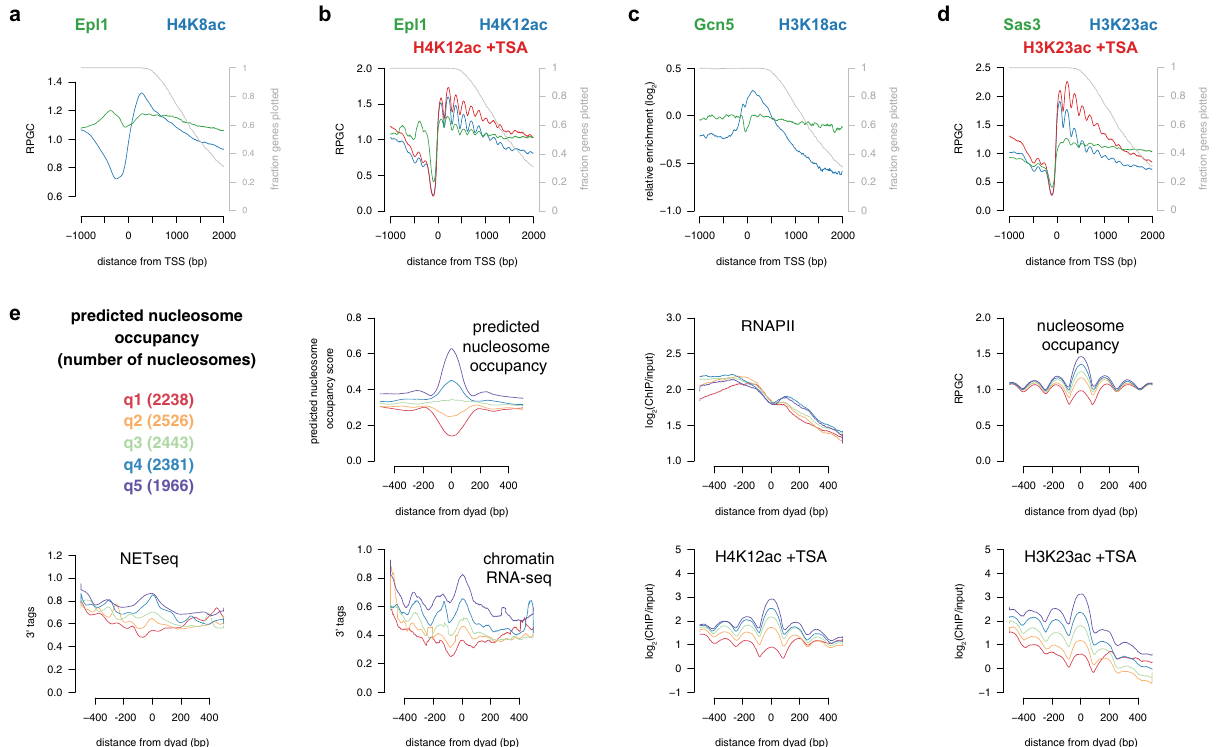
Fig. 3 The activity of histone acetyltransferases are regulated post-recruitment. a , b Average pro fi les of Epl1 (green) and H4 acetylation (blue) ChIP from sonicated 27 ( a ) or MNase-digested chromatin ( b ) at 832 unidirectional promoter genes aligned by the TSS. Only data until the PAS was included, and the gray line represents the fraction of genes plotted for each position. Data from TSA-treated cells (red) was normalized to untreated wild-type (see “ Methods ” ). RPGC reads per genomic coverage, TSS transcription start site. c , d Average pro fi les of Gcn5 (green) and H3K18ac (blue) ChIP 75 from sonicated chromatin ( c ) and Sas3 (green) and H3K23ac (blue) ChIP from MNase-digested chromatin ( d ) at 832 unidirectional promoter genes aligned by the TSS. e Genic nucleosomes 47 in the middle quintile for RNAPII occupancy [log 2 (Rpb3/input) 50 bp upstream and downstream of the nucleosome dyad] were divided into quintiles based on predicted nucleosome occupancy 48 over the same region. Shown are pro fi les upstream and downstream of the nucleosome dyad for predicted nucleosome occupancy, RNAPII (Rpb3 ChIP-seq 73 ), nucleosome occupancy (MNase-seq), NET-seq 41 , chromatin RNA- seq 41 , and nucleosome-normalized H4K12ac and H3K23ac 33 ChIP-seq from TSA-treated cells for the fi rst (red), second (orange), third (green), fourth (blue), fi fth (purple) quintiles for predicted nucleosome